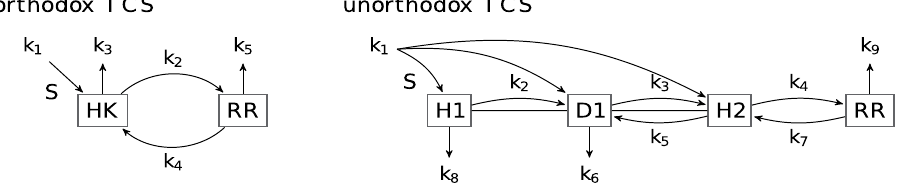
Figure 7. Two different bacterial two-component systems (TCS). Reactions involving phosphate groups are represented by arrows with the respective reaction rates indicated. Left: the “orthodox system”, in which the histidine kinase (HK) auto-phosphorylates upon sensing a stimulus S and passes the phosphate group on to the response regulator (RR) protein. The orthodox system has two phosphate binding domains. Right: the “unorthodox system”, in which the HK has three binding domains: H1, D1, and H2. Together with the binding domain on the RR, this system has a total of four phosphate binding